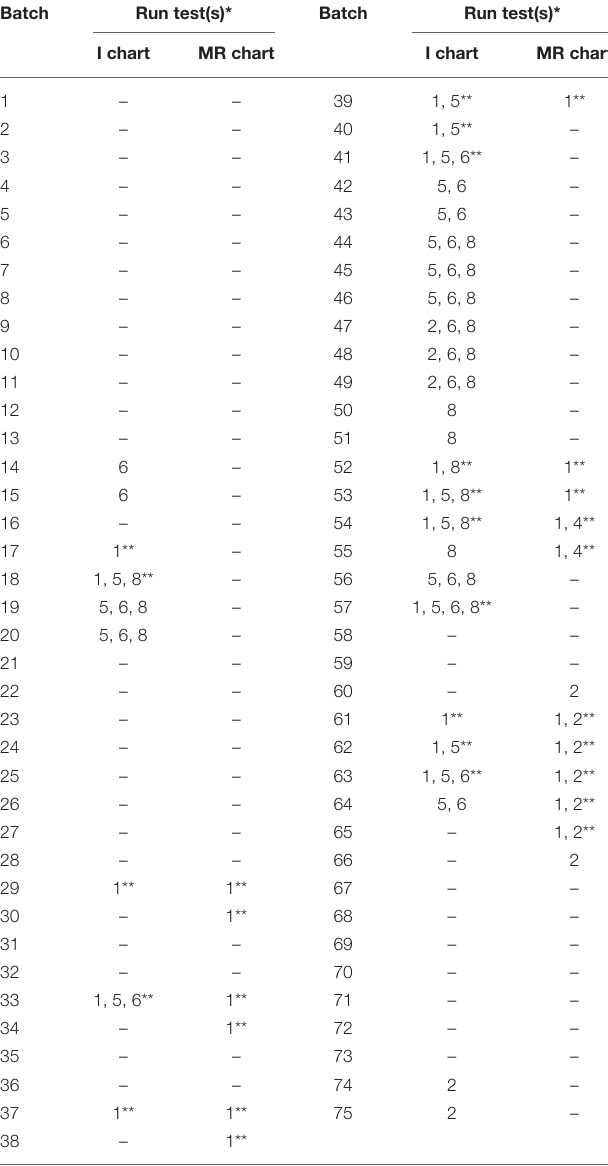
TABLE 1 | List of special cause variations (run tests) for mortality (%) in each batch related to the I-MR chart obtained from the analysis of the 3 Periods (Period 1 = 1–28; Period 2 = 29–63; Period 3 =